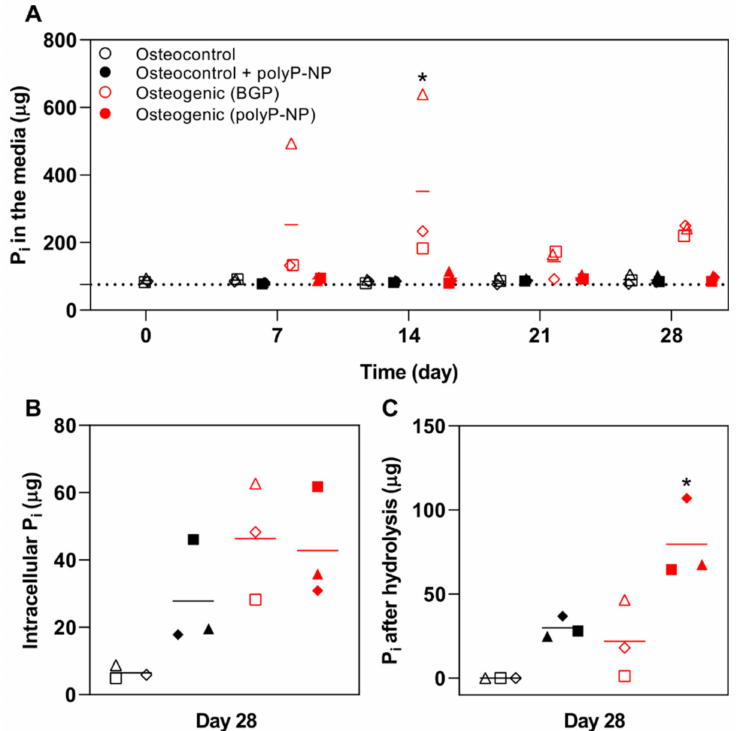
Figure 4. Quantification of free phosphate (P i ) levels. Human BM-MSCs are cultured in osteocontrol media ± polyP-NP, or osteogenic medium containing either BGP or polyP-NP, for 28 days. ( A ) Conditioned media samples are collected at days 7, 14, 21 and 28 and P i levels in the media samples are determined. The dashed line at 86 µ g / mL represents the detected P i concentration in LG-DMEM without additional supplementation. Two-way ANOVA is performed; *( p < 0.001 vs. osteogenic; p < 0.001 vs. osteocontrol + polyP-NP; p < 0.05 vs. osteocontrol (polyP-NP)); ( B ) Intracellular P i concentrations in cell lysates of the di ff erent treatment groups at day 28; ( C ) Total potential P i in the cell lysates is assessed following acid hydrolysis. One-way ANOVA is performed; *( p < 0.001 vs. osteocontrol; p < 0.05 vs. osteocontrol + polyP-NP; p < 0.05 vs. osteogenic (BGP)). Data are shown as the mean of two technical replicates for each individual donor: donor A ( (cid:3) ), donor B ( ∆ ) and donor C ( ♦ ). The mean of the three independent donors within each group is indicated by the horizontal